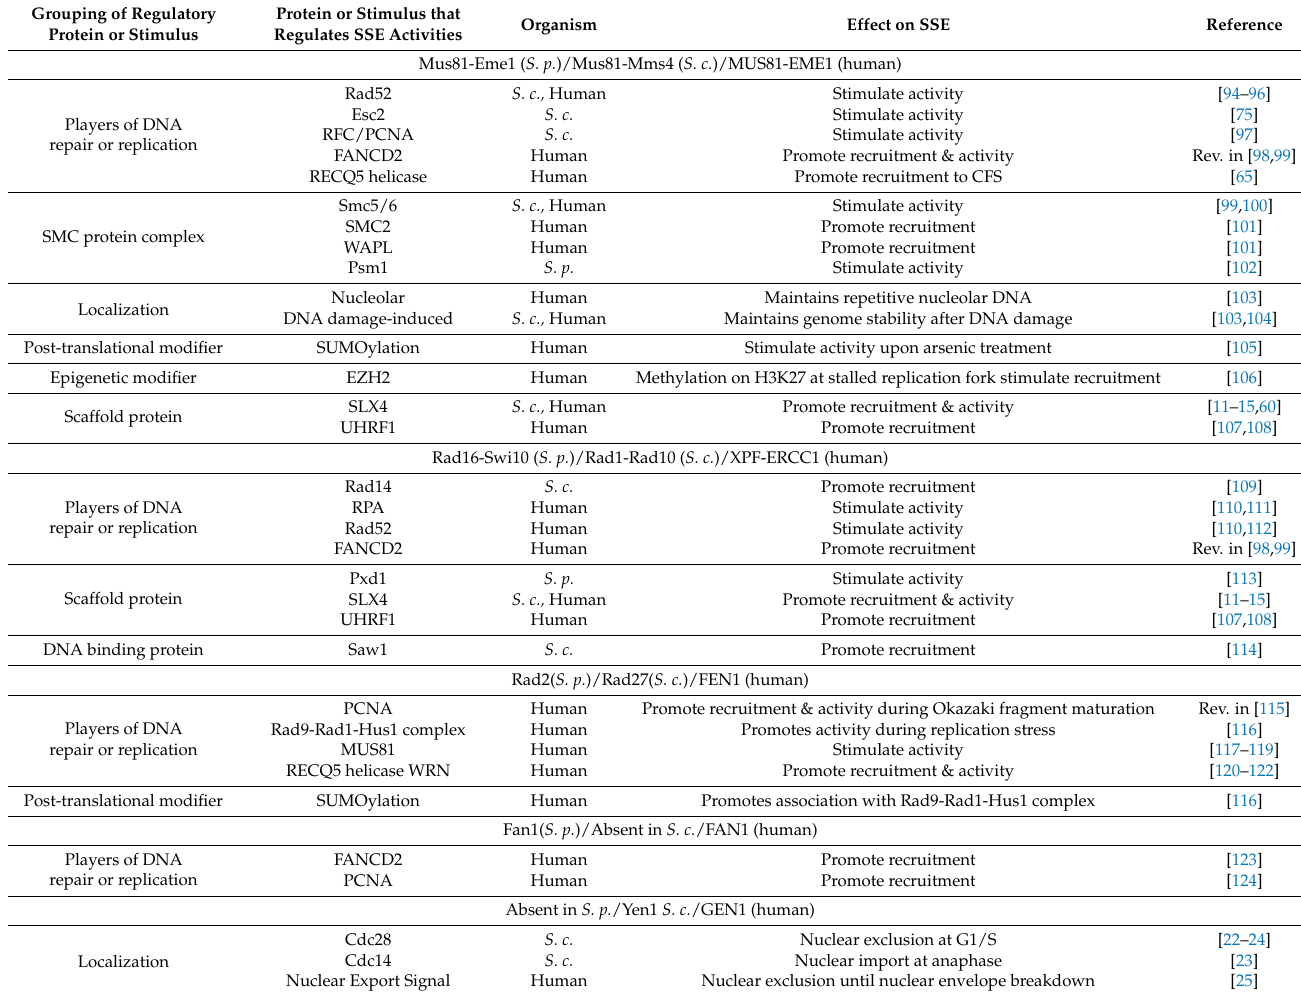
Table 1. Regulators of structure-specific endonucleases (SSEs) besides cell cycle kinases and Cds1 S.p. homologs. There are many other regulators of Mus81 and other SSE activities besides cell cycle-dependent kinases. Proteins involved in DNA repair or replication are the most common regulators. ( S.c.: S. cerevisiae; S.p.: S. pombe